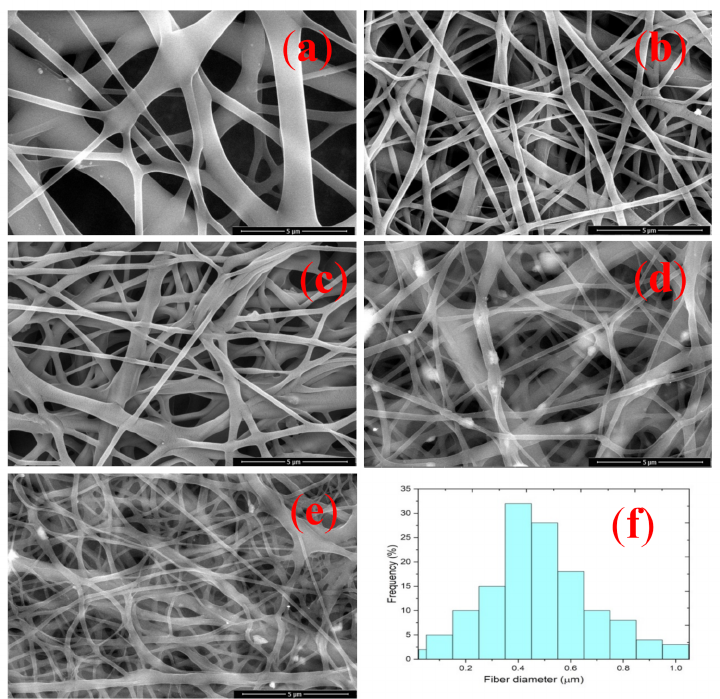
Figure 6. ( a – e ) FESEM micrographs of PCL scaffolds encapsulated with co-doped Ag/V-HAP in nanofibrous phase: ( a ) 0.0 Ag/V-HAP@PCL, ( b ) 0.2 Ag/V-HAP@PCL, ( c ) 0.4 Ag/V-HAP@PCL,